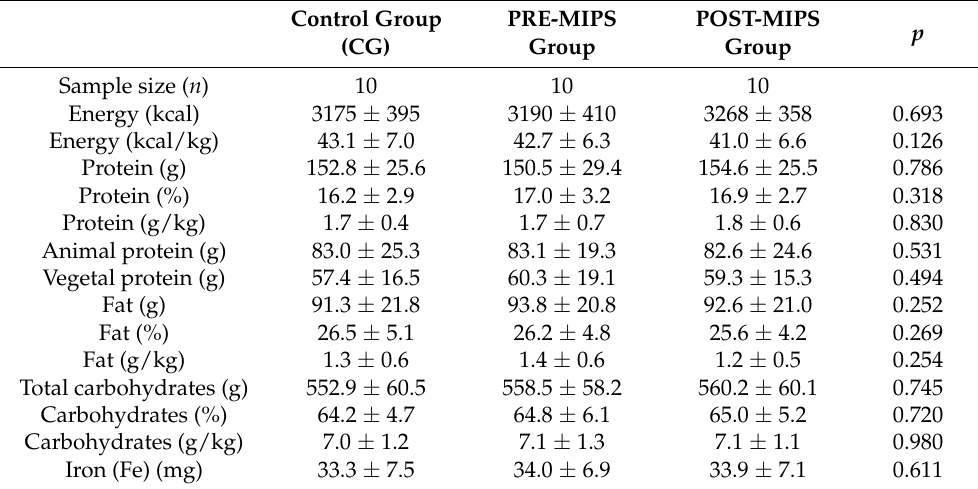
Table 2. Energy, macronutrient, and iron intake in the three study groups during 10 weeks of study.